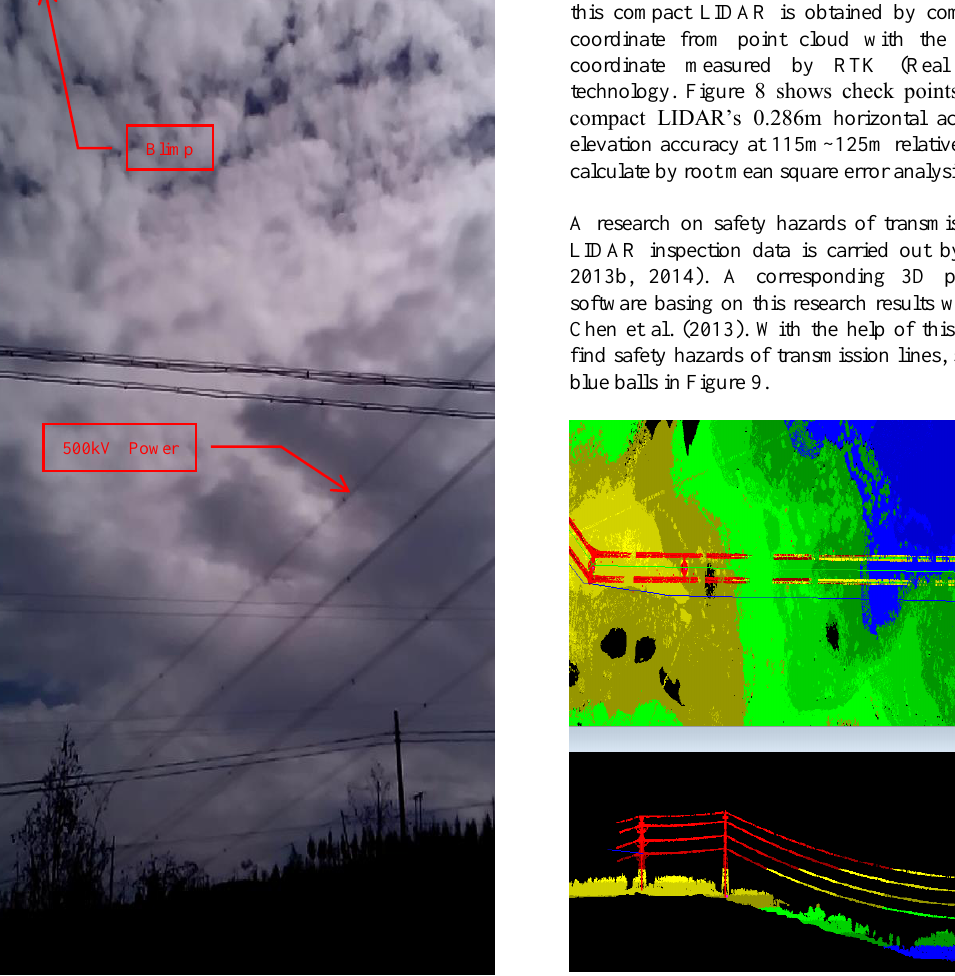
Figure 7. Laser point clouds of power